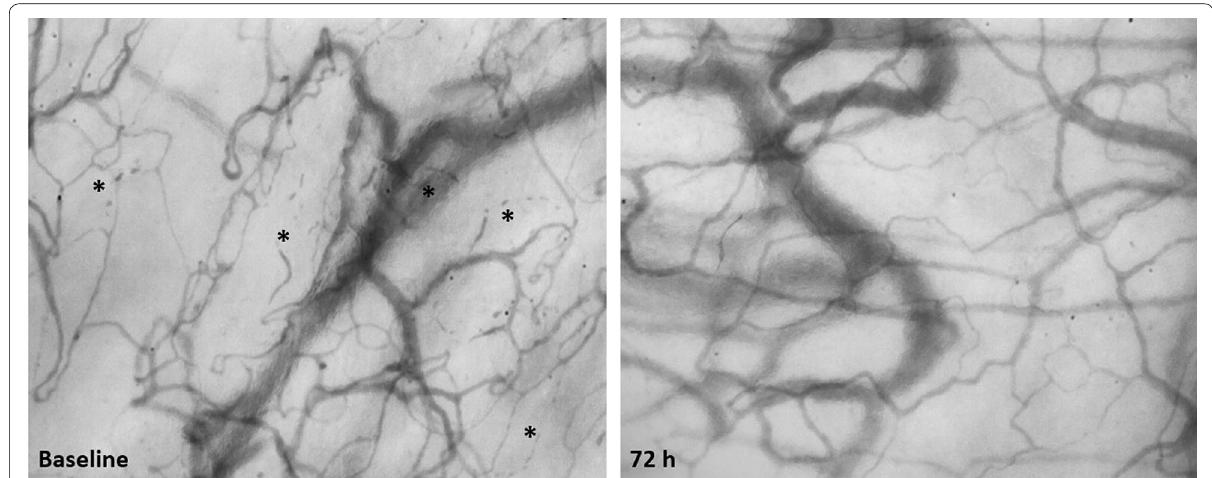
Fig. 4 Images of the sublingual microcirculation of a patients at baseline and after 72 h of Pentaglobin infusion. Non-perfused vessels are indicated with